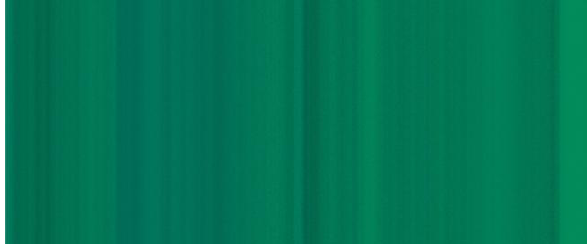
Figure 5: Synthetic image with 3D point cloud RGB values, having lost the spatial component of each